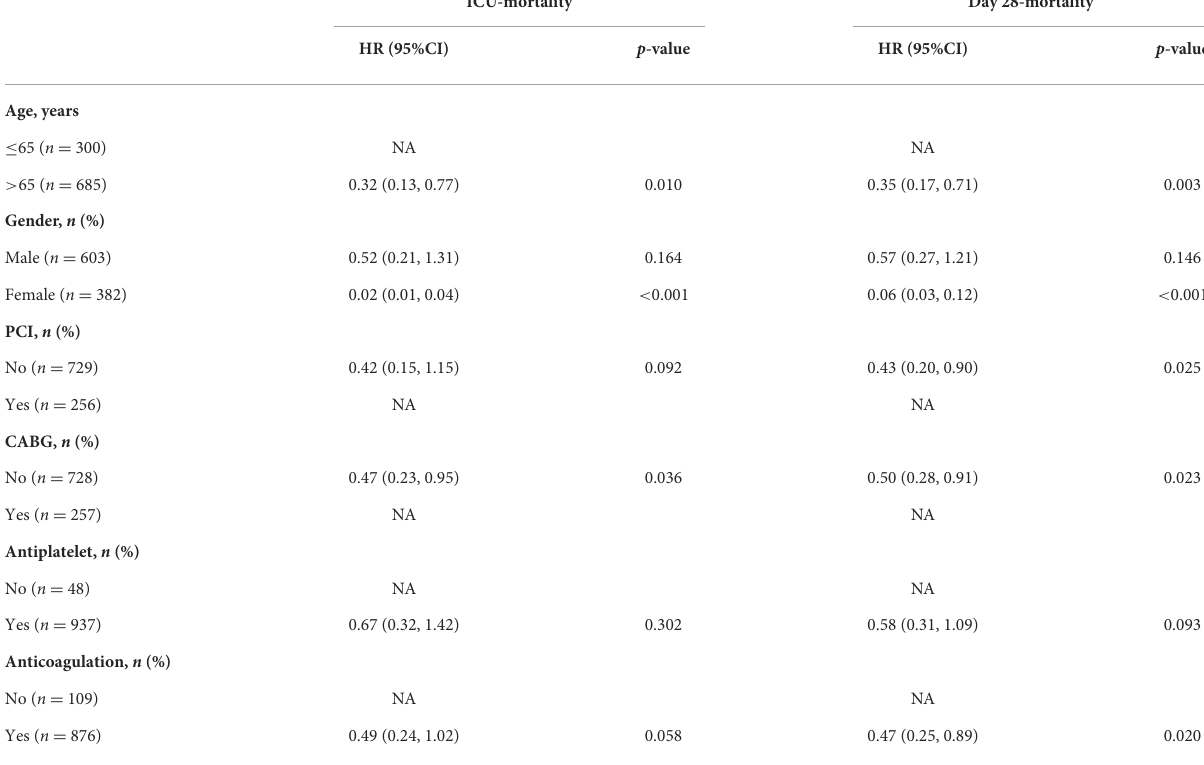
TABLE 3 Subgroup analysis of the associations between AE-therapy and